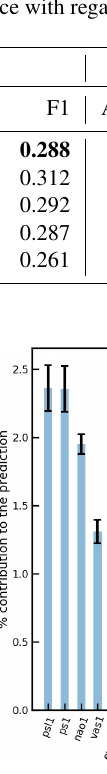
Figure 5. Mean Shapely values normalized to the contribution to the prediction for the top 15 variables, with the highest importance for Lisbon (a) and Munich (b) in the test dataset. The number be- hind the variable name refers to the number of months before the event (NAO1–NAO value 1 month before the predicted event). The results indicate that for the Lisbon domain psl1 and ps1 are the most influential drought predictors; for Munich this is